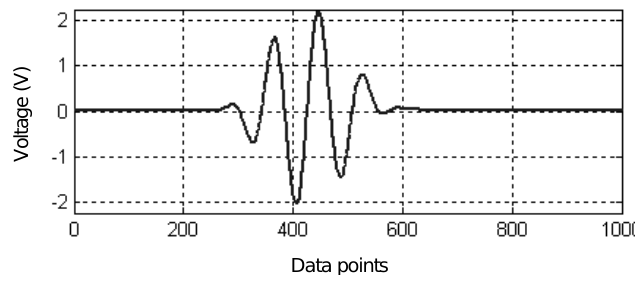
Fig. 9. Lamb wave input excitation at 300